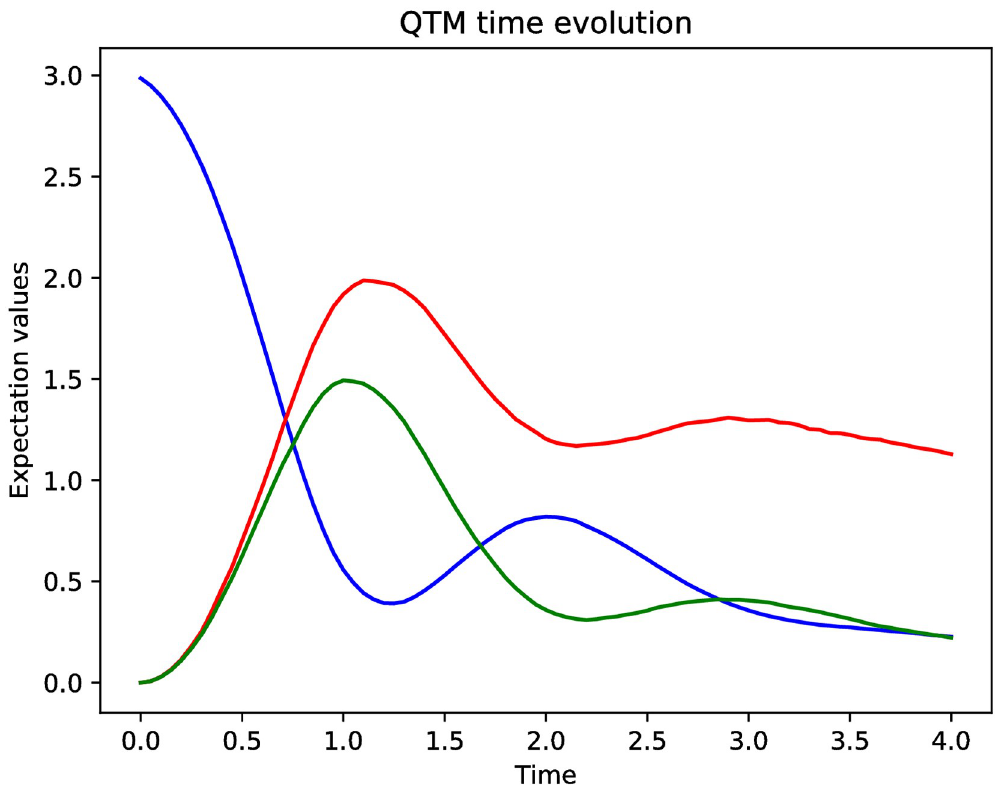
Fig 6. The expectation values describing the number of photons for different expectation operators (N0—Blue, N1— Red, N2—Green defined by Eq (22)) for a trilinear Hamiltonian—Eq (20).